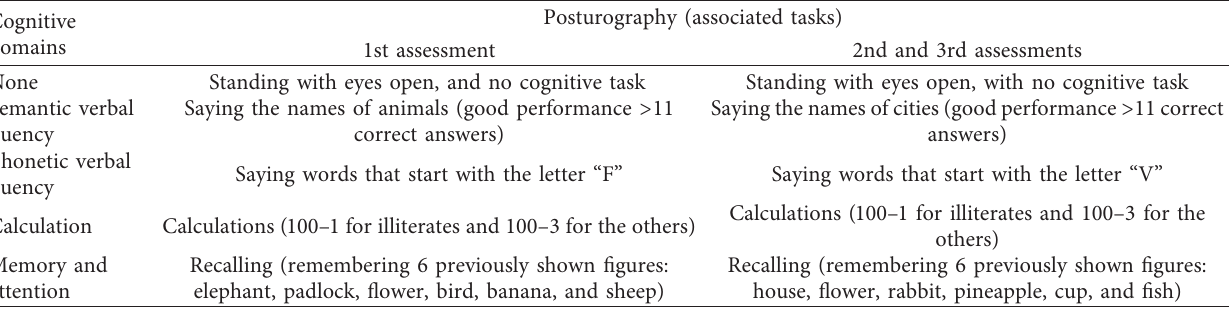
Table 1: Description of associated tasks to assess dual-task performance on the force